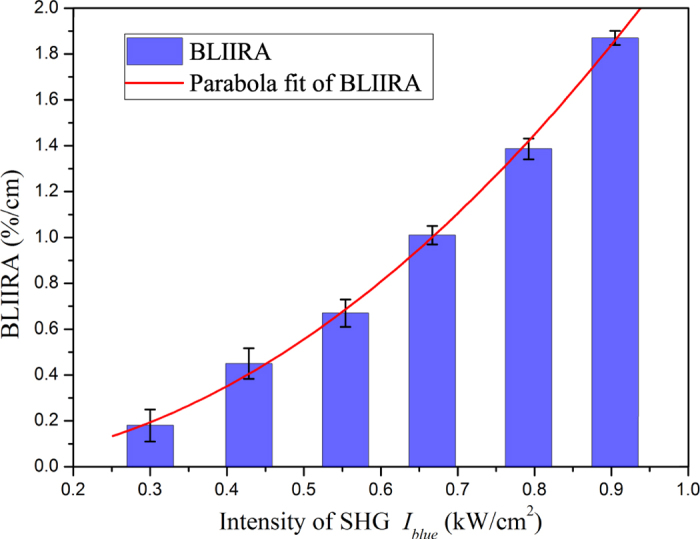
BLIIRA coefficient αBLIIRA as a function of the intensity of 397.5 nm laser Iblue; the data is fitted with  (Iblue: kW/cm2).